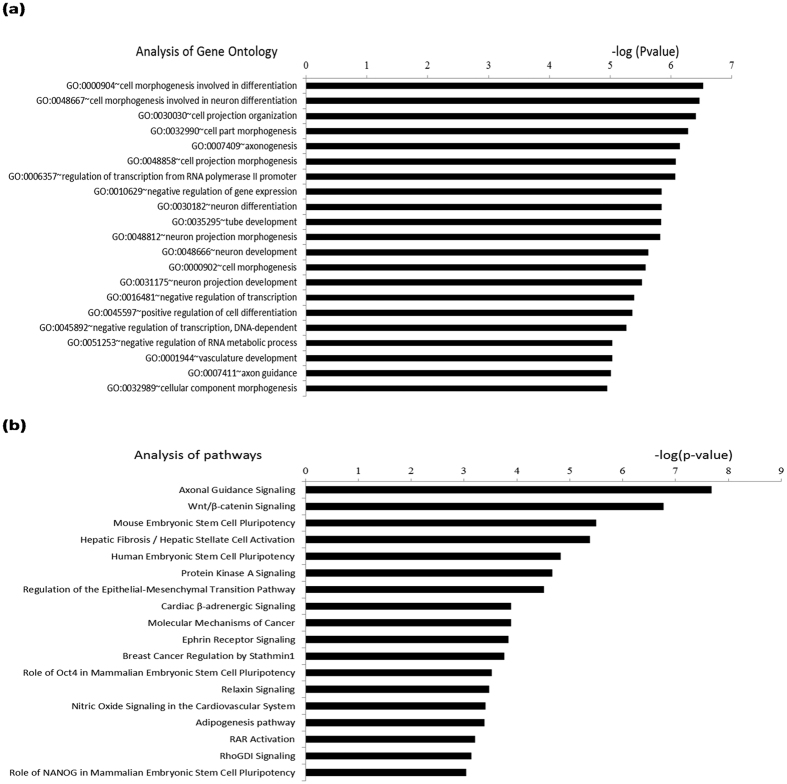
Analysis of GO and Pathway for HIF-2α annotated genes in BEAS-2B.(a) Analysis of GO was achieved by using DAVID, in which we adopted Gene Ontology/GOTERM_BP_FAT. Fold Enrichment >1.5 and P-Value, Bonferroni and FDR <0.05 were set as criteria for analysis. (b) Analysis of pathway by IPA and top 20 are shown according to the value of −log (P value).